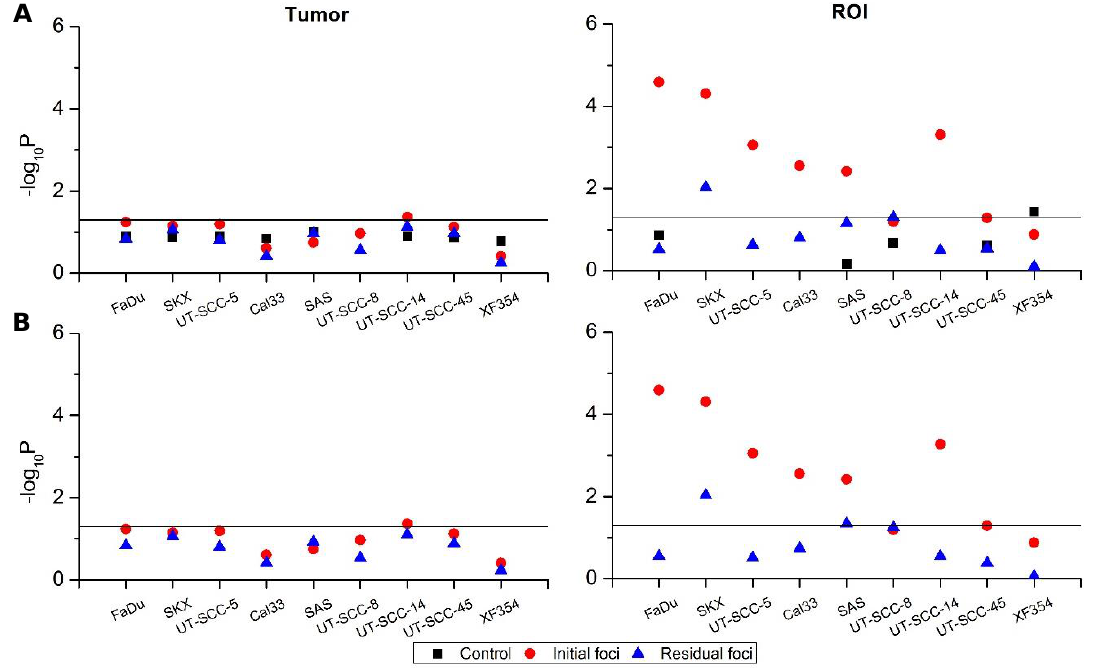
Figure 3. Heterogeneity of corrected foci (cfoci, upper row ) and normalized foci (nfoci g , lower row ) for the in vivo set-up determined by a linear mixed-effects model (LMEM). Scatter plots of −log 10 P values according to the analysis chain of LMEM (black-square: control, red-circle: initial foci, blue-triangle: residual foci) for cfoci ( A ) and nfoci g ( B ). No fixed effect was defined; tumor and ROI were set as random effects. cfoci represents the ratio of foci number and nucleus area of an individual cell multiplied by the mean nucleus area of the corresponding tumor, whereas nfoci is cfoci of an individual nucleus normalized by the mean cfoci of the unexposed tumors (for details see Section 4). Solid lines indicate the significant threshold ( p = 0.05, above the line: p < 0.05). Exact p values are given in Supplementary Tables S5 and S6.